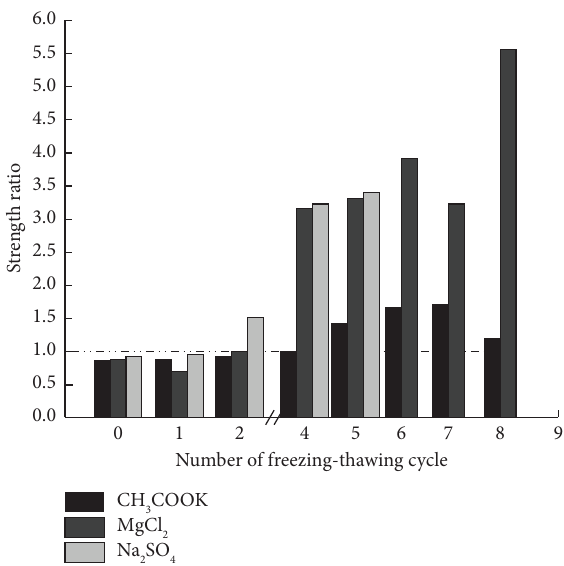
Figure 20: Stress-strain relationship curve of the glass fber- reinforced cemented soil after 5 freezing-thawing